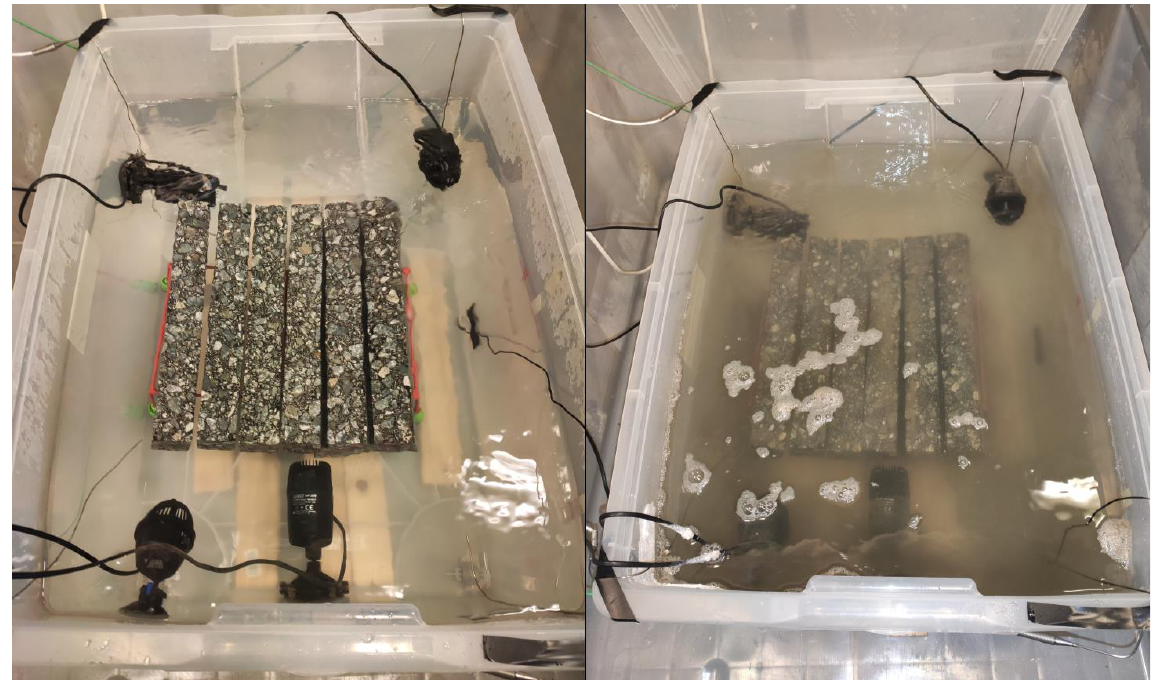
Figure 5. Armed container before (left hand side) the road salt dosage and after experiment (right hand side).